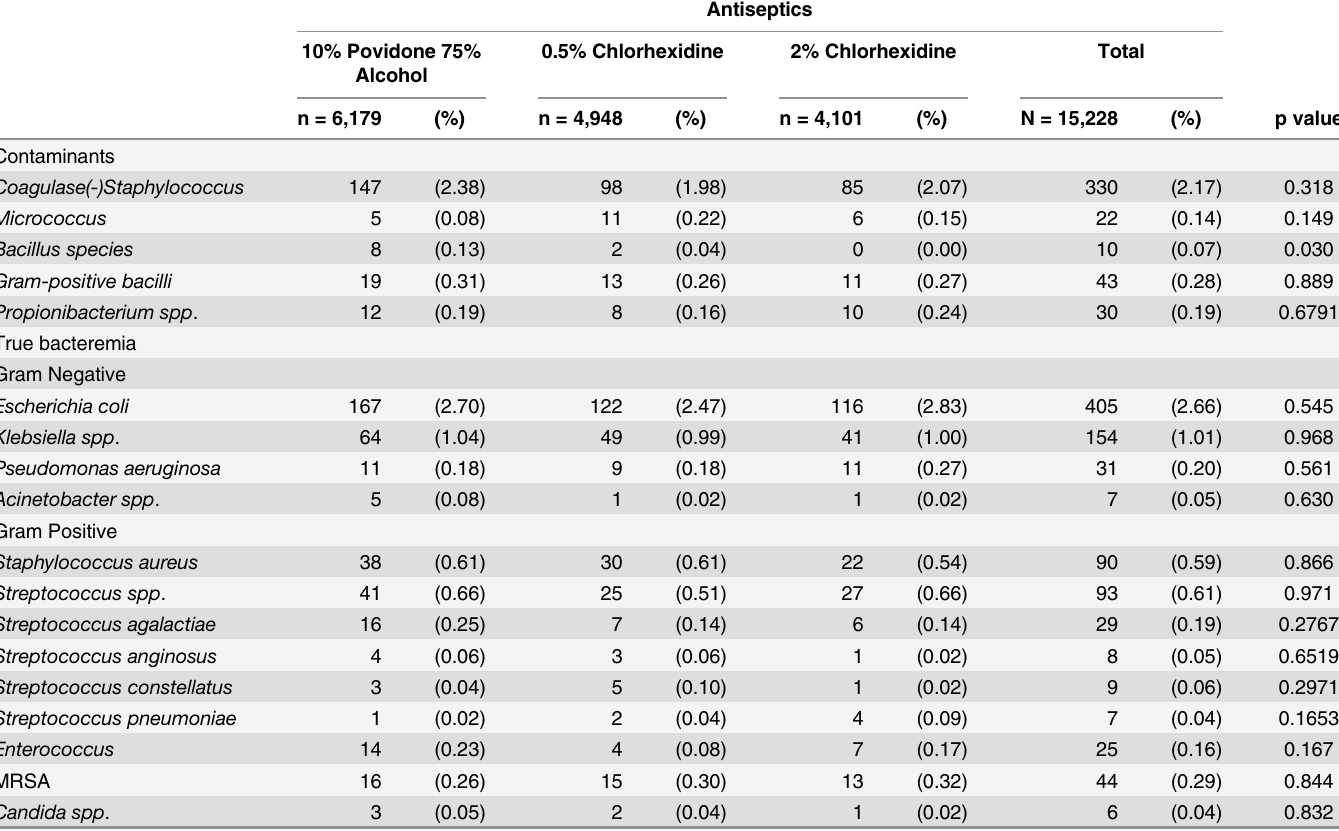
Table 3. Microorganisms isolated from patients receiving different anti-septic agents before blood cultures in the